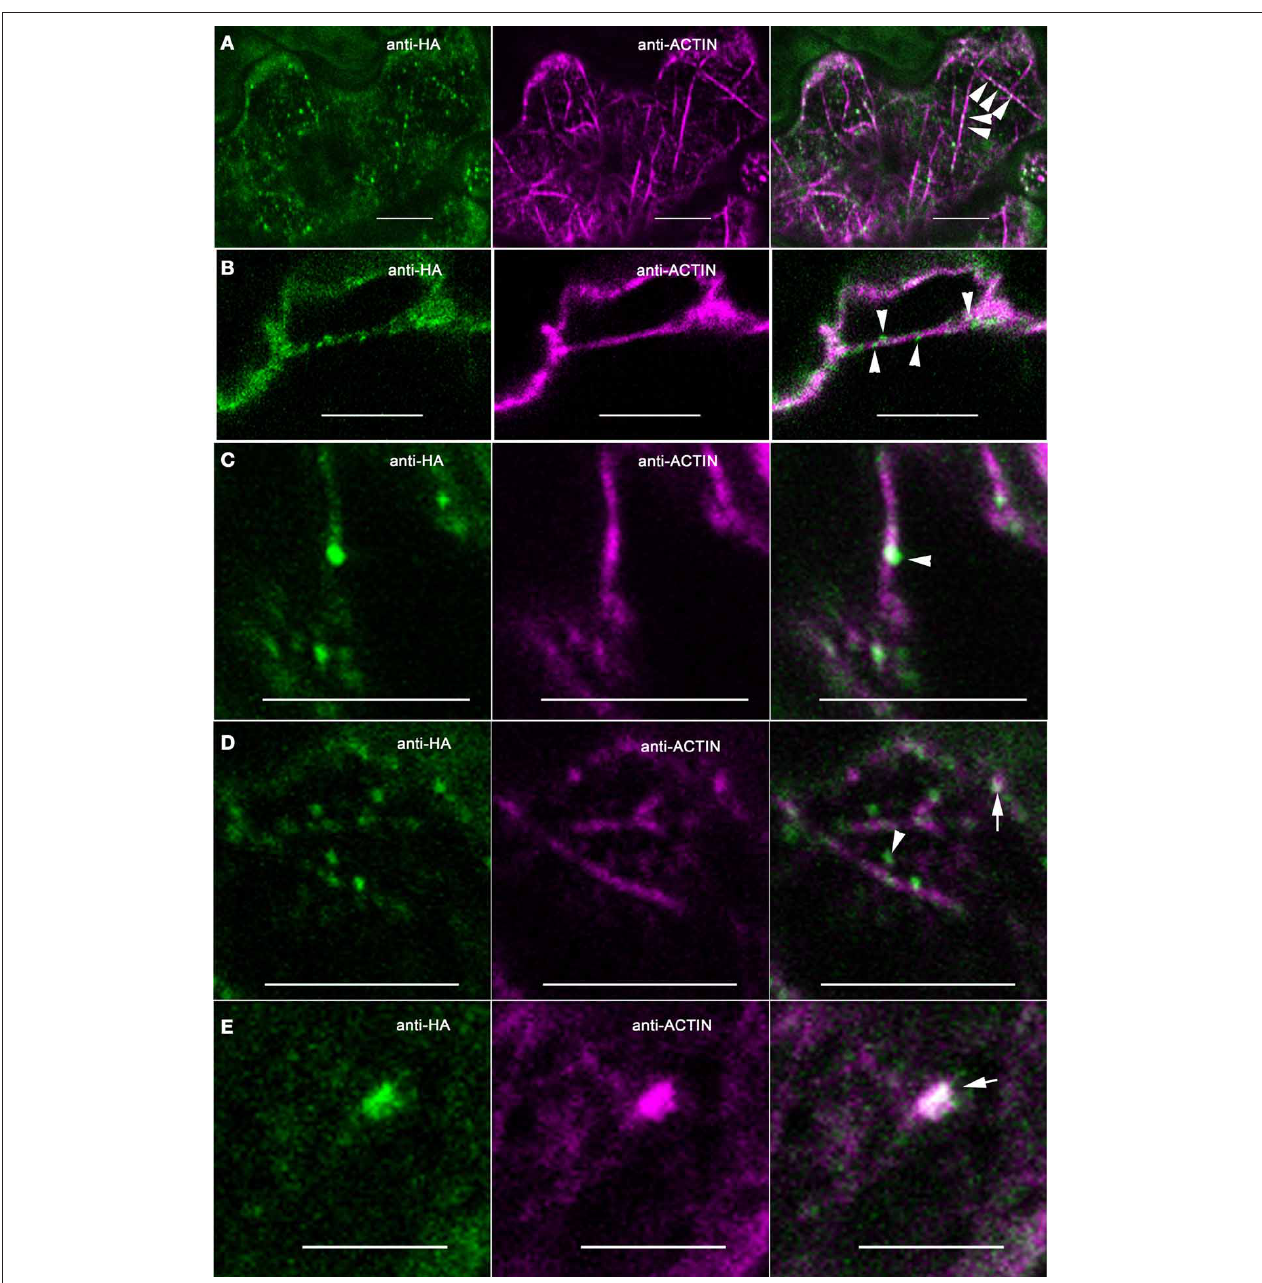
FIGURE 5 | ARP2/3 partially colocalizes with multiple actin networks in pavement cells. Single plane confocal images from double-labeled pavement cells. (A) Some granular ARPC4 structures decorate along actin bundles, as indicated by the arrowheads in the right panel. (B) . Some granular ARPC4 structures are associated with actin bundles in the transvacuolar strands as indicated by the arrowheads. (C) Example of punctate ARPC4 adjacent to an actin bundle, as indicated by the